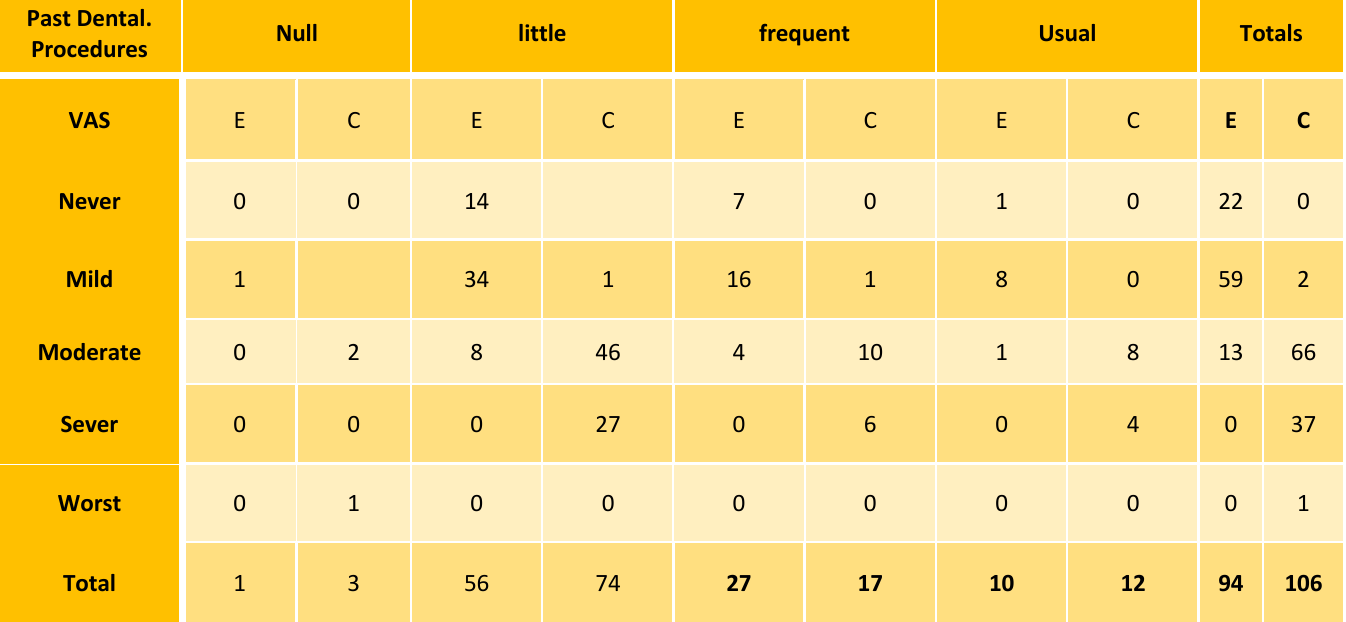
Table 7. Distribution of sample according to past dental